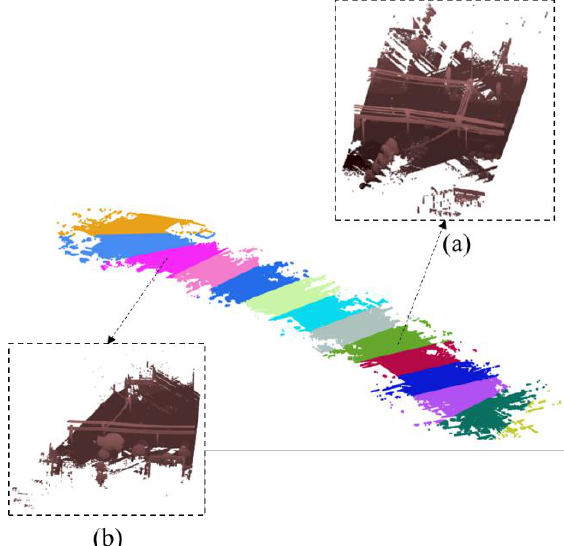
Figure 7. Sectioning of point cloud. (a) and (b) are two sample sections.